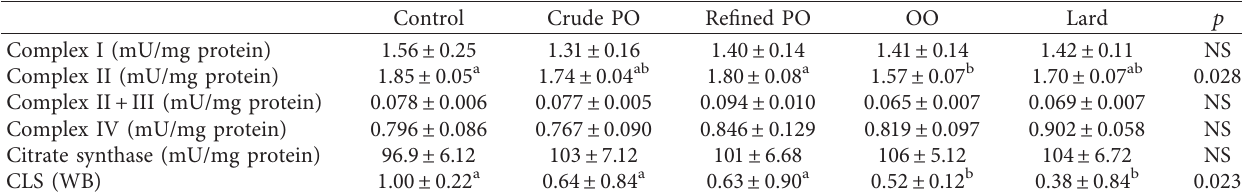
Table 5: Variation in mitochondrial enzyme activity.